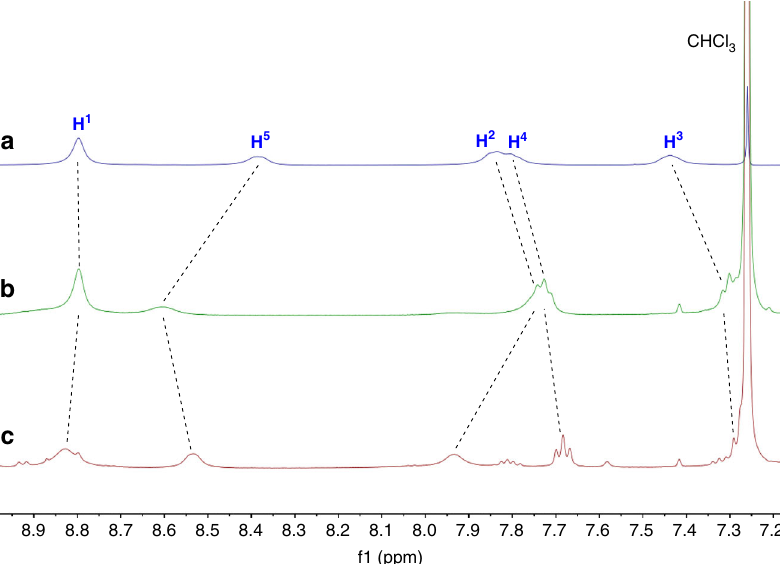
Fig. 5 Partial 1 H NMR (500 MHz, CDCl 3 , 25 °C) spectra of 5 and 5 2 (cid:129) 8 . a 1 H NMR spectrum of 5 . b 1 H NMR spectrum of 5 2 (cid:129) 8 . c 1 H NMR spectrum of a mixture of 5 2 (cid:129) 8 and n -Bu 4